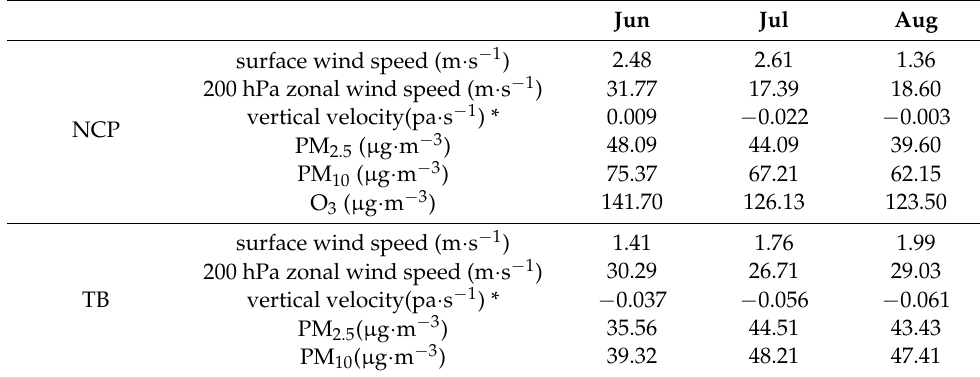
Table 2. The average value of the meteorological elements and pollutant concentrations in the North China Plain (NCP) and Tarim Basin (TB) in June, July and